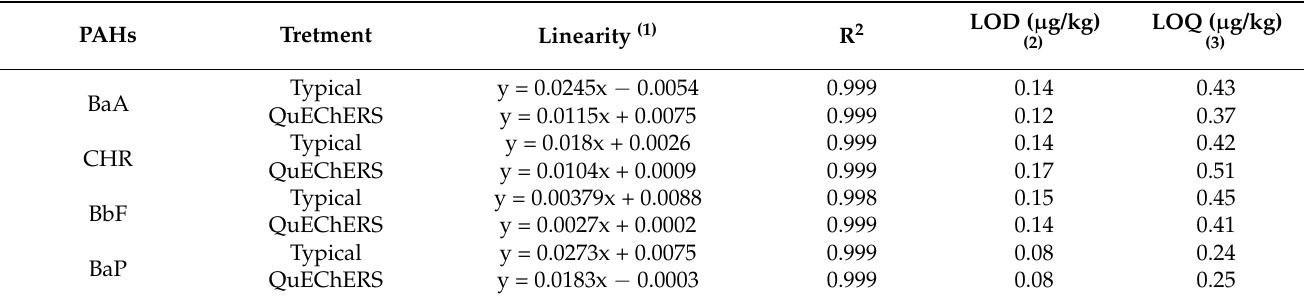
Table 1. Comparison of typical sample treatment and QuEChERS in regard with linearity with equation of calibration, limit of detection (LOD), and limit of quantification (LOQ) of PAH4 in herbal medicine. PAHs